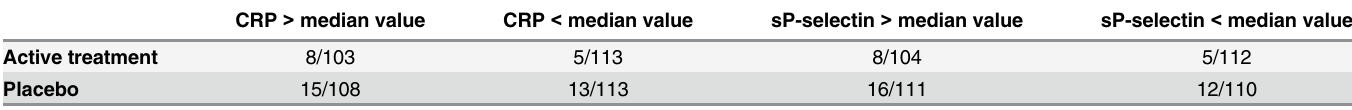
Table 3. Distribution of cardiovascular mortality in placebo and active treatment groups above and below median value of C-reactive protein, and sP-selectin in the study population during 5 years of